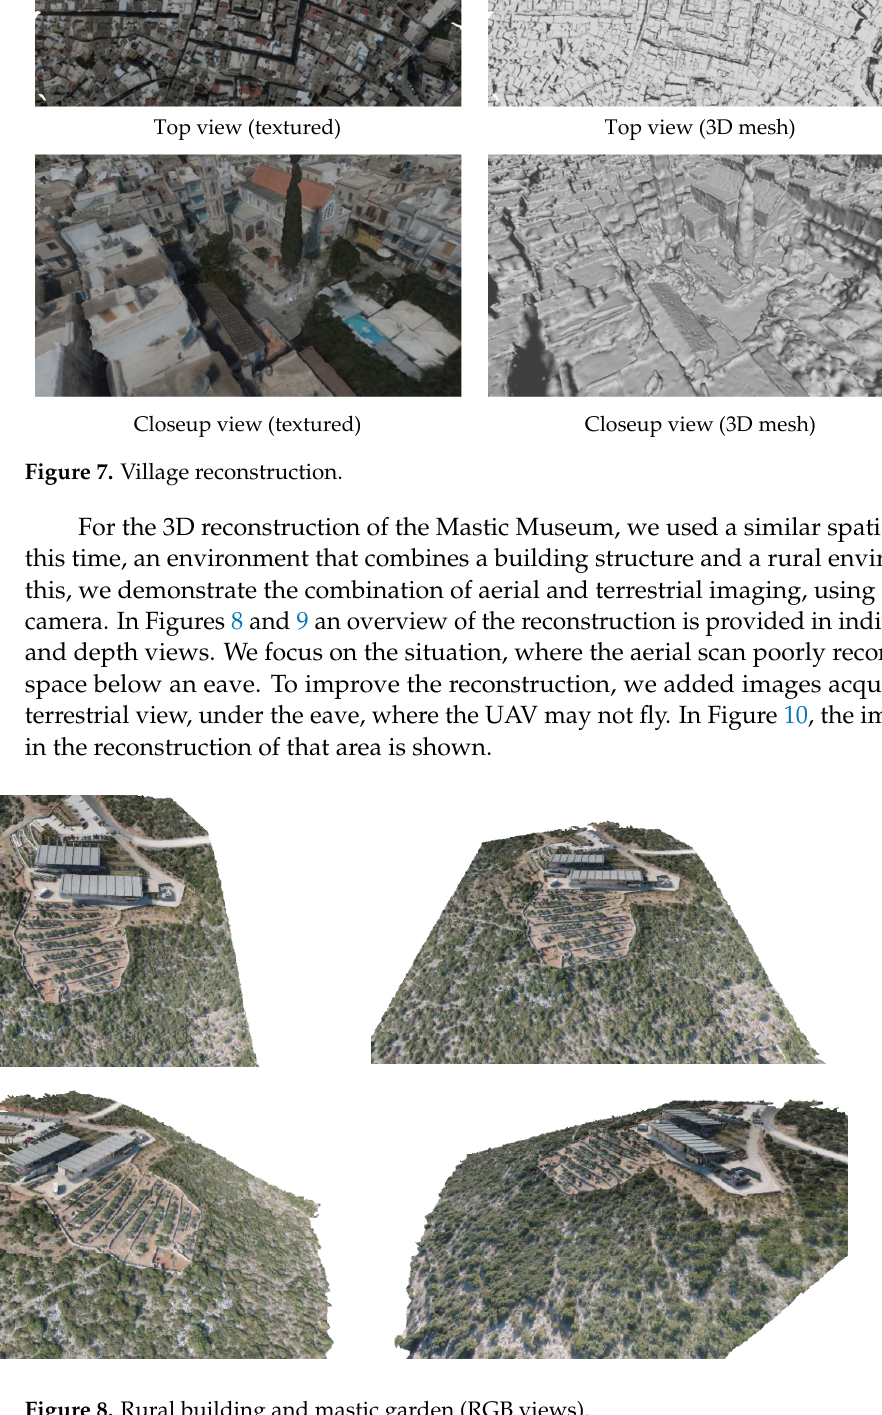
Figure 9. Rural space and building (depth view).